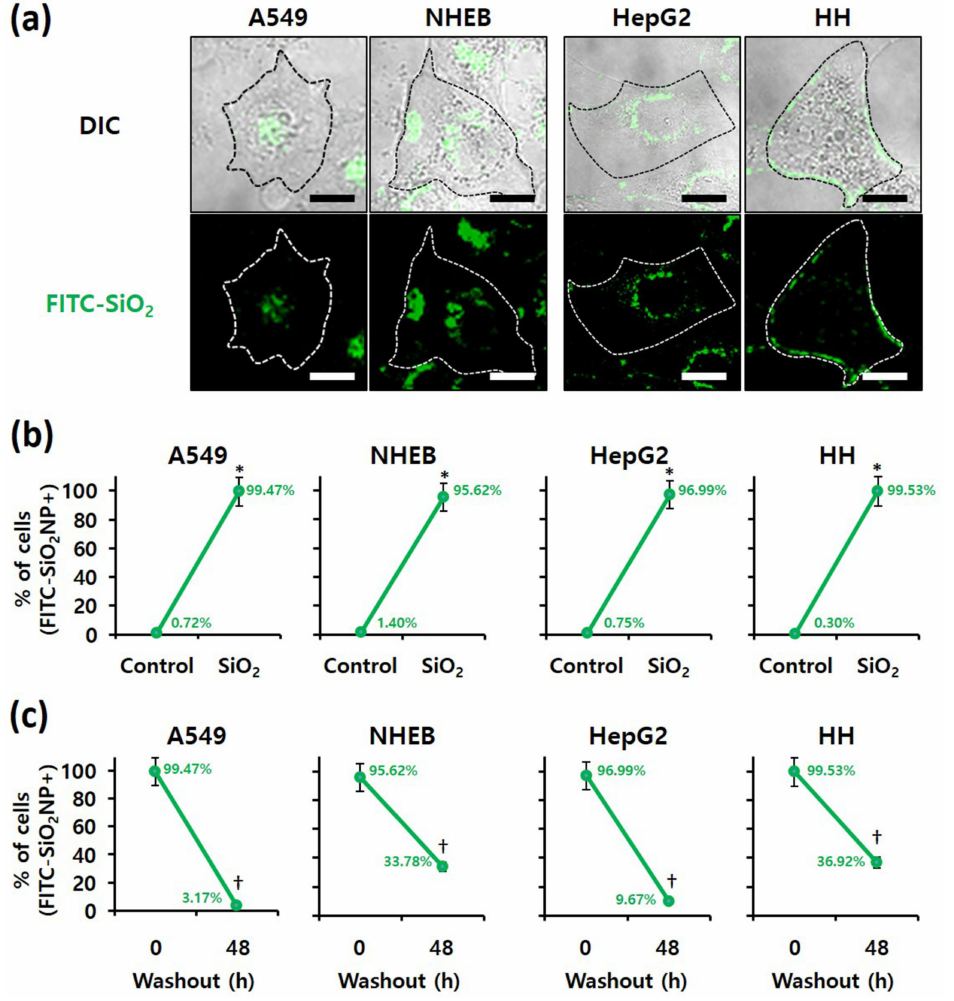
Figure 5. Examination of SiO 2 NPs retention in cells; Localization of fluorescein isothiocyanate (FITC)-labeled 20 nm SiO 2 NPs in each cell line, as determined by ( a ) confocal fluorescence microscopy (scale bars represent 10 µ m) and ( b ) flow cytometry after 4 h of treatment. * p < 0.005, compared with control. ( c ) Retention of FITC-labeled 20 nm SiO 2 NPs in each cell line, as determined by flow cytometry at 0 and 48 h after 4 h of treatment. † p < 0.005, compared with washout for 0